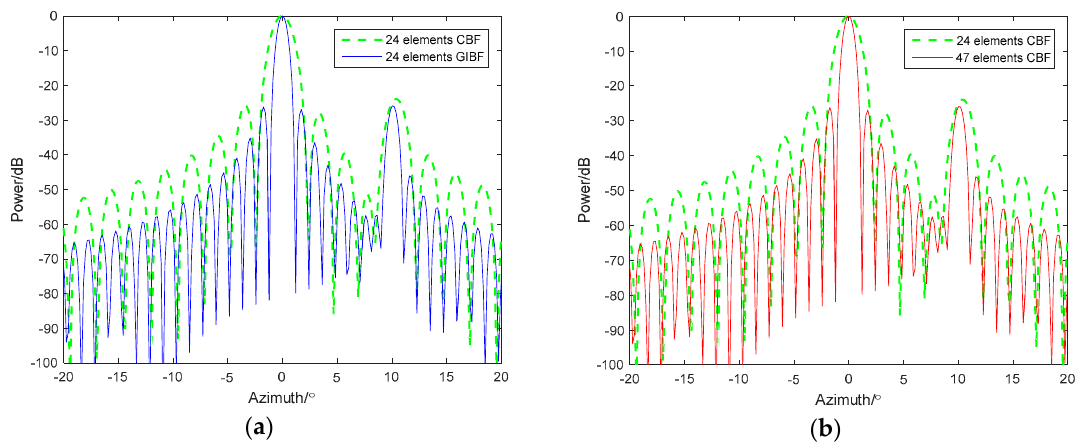
Figure 3. Comparison between ( a ) CBF and GIBF with 24 sensors and ( b ) CBF with a 24-element array and CBF with 47 elements.